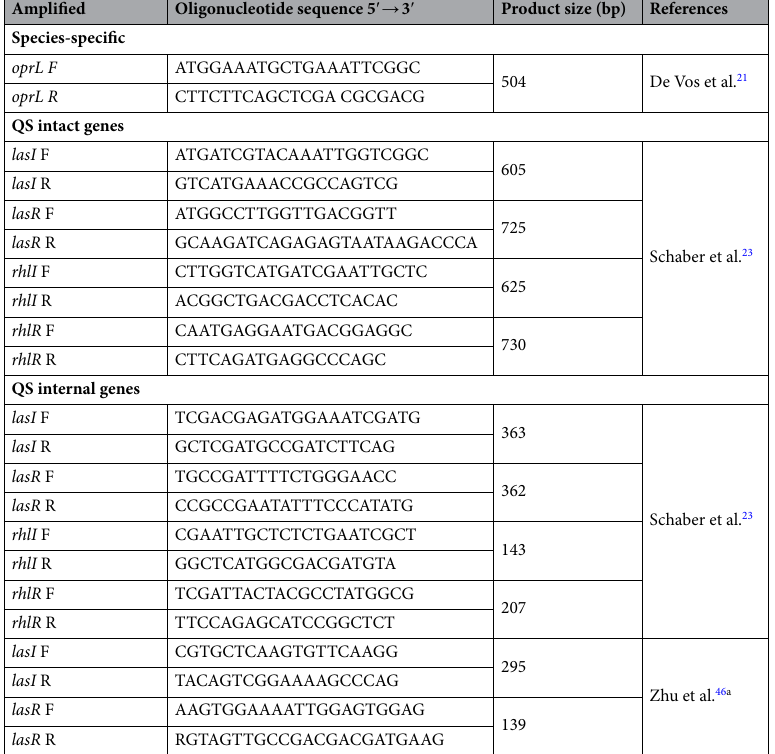
Table 1. Primers used in this study. a It was applied only for AHL positive